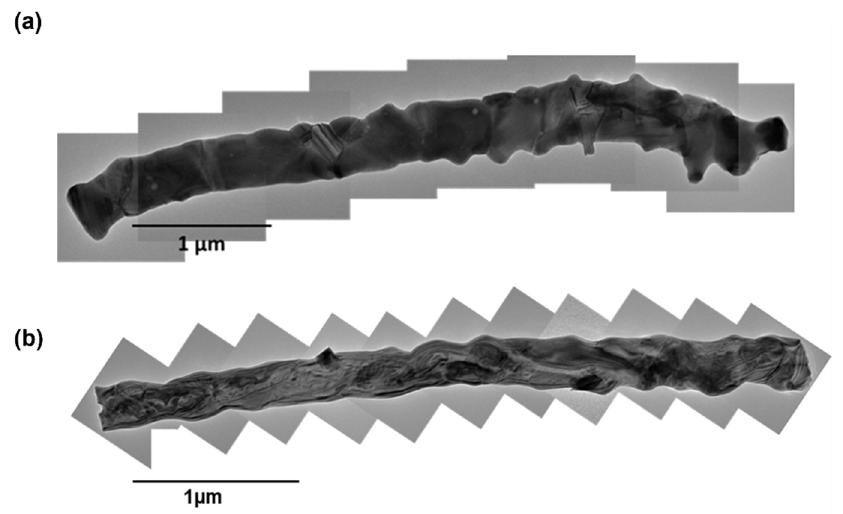
Figure 7. ( a ) Merged TEM image of R3m CuYO 2 nanofibers, ( b ) merged TEM image of P63/mmc CuYO 2 nanofibers.